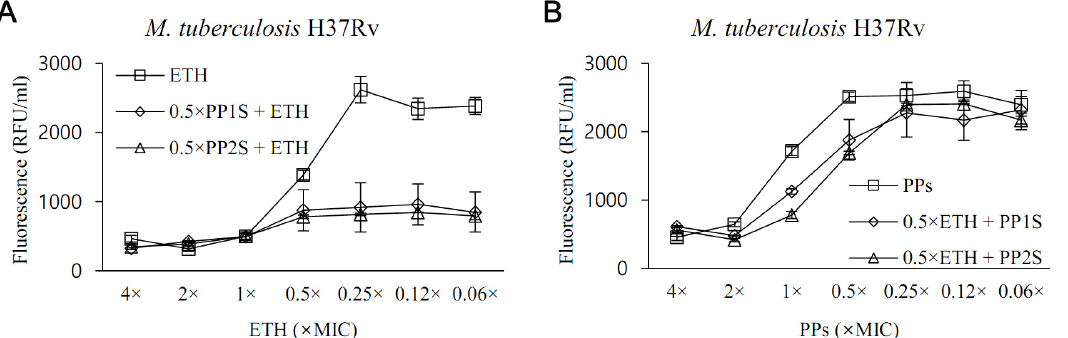
Figure 2. Interaction between Rv0560c protein and EthR protein. ( A ) A protein microarray experi- ment using biotinylated Rv0560c protein confirmed that Rv3855 (EthR) had the most potent inter- action with Rv0560c protein among all proteins of M. tuberculosis . ( B ) The interaction of EthR with Rv0560c was verified through SPR (surface plasmon resonance).